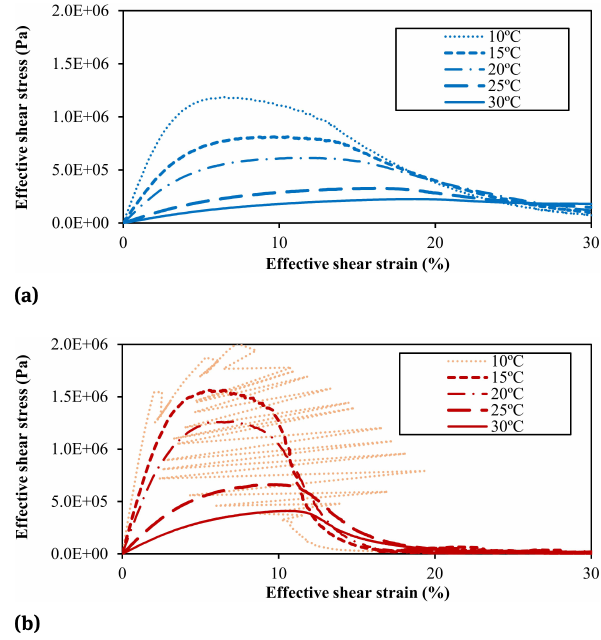
Figure 2: Stress-strain curves from (a) HPMB and (b) AC